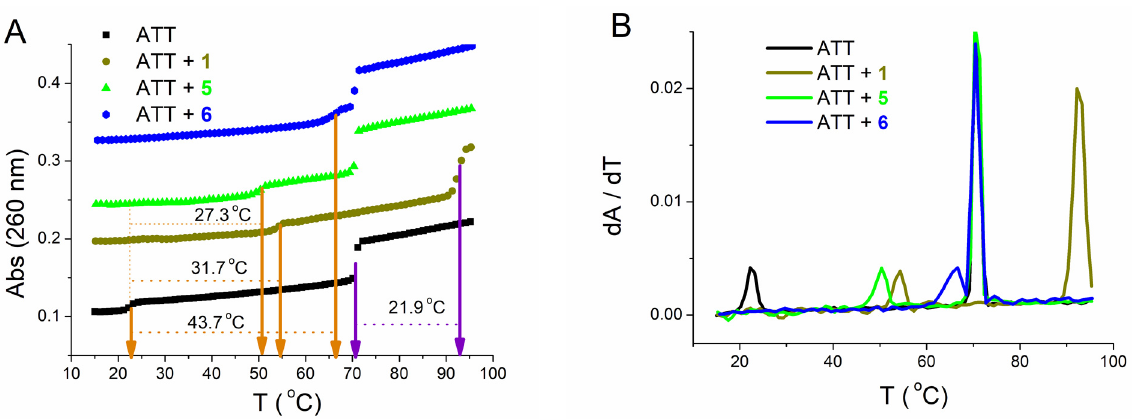
Figure 7. ( A ): Melting curve of ATT triplex upon addition of ratio, r ([compound/[polynucleotide]) = 0.1 of 1, 5, and 6 at pH = 7.0 (sodium cacodylate buffer with NaCl, I = 0.1 mol dm − 3 + 1 mM EDTA; orange arrows—first transition, violet arrows—second transition); ( B ): First derivative of absorbance at 260 nm in dependence of temperature.